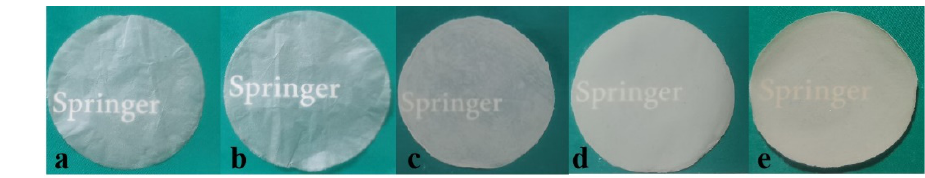
Figure 5. The images of the composite films (( a – e ) were PEI 0%, PEI 5%, PEI 10%, PEI 15%, and PEI 20%).